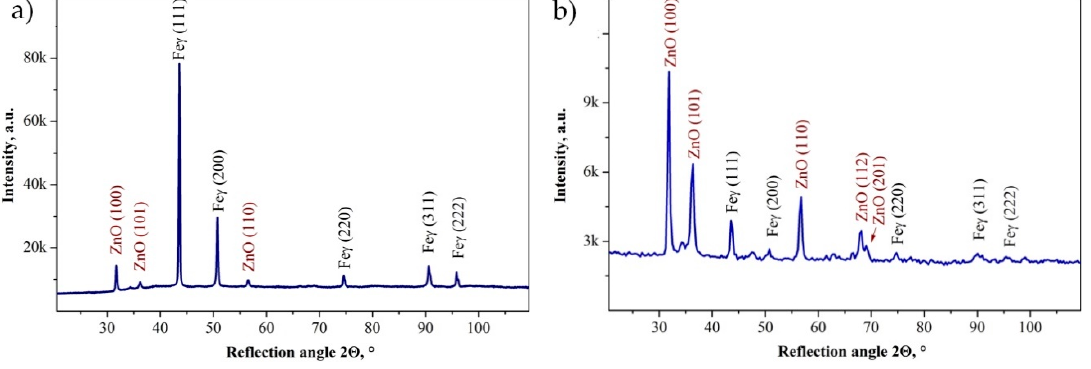
Figure 6. X-ray di ff raction pattern of ZnO coating deposited on the Cr-Ni-Mo steel substrate obtained by the ( a ) Bragg-Brentano method and the ( b ) GIXRD method ( α = 1 ◦ ).